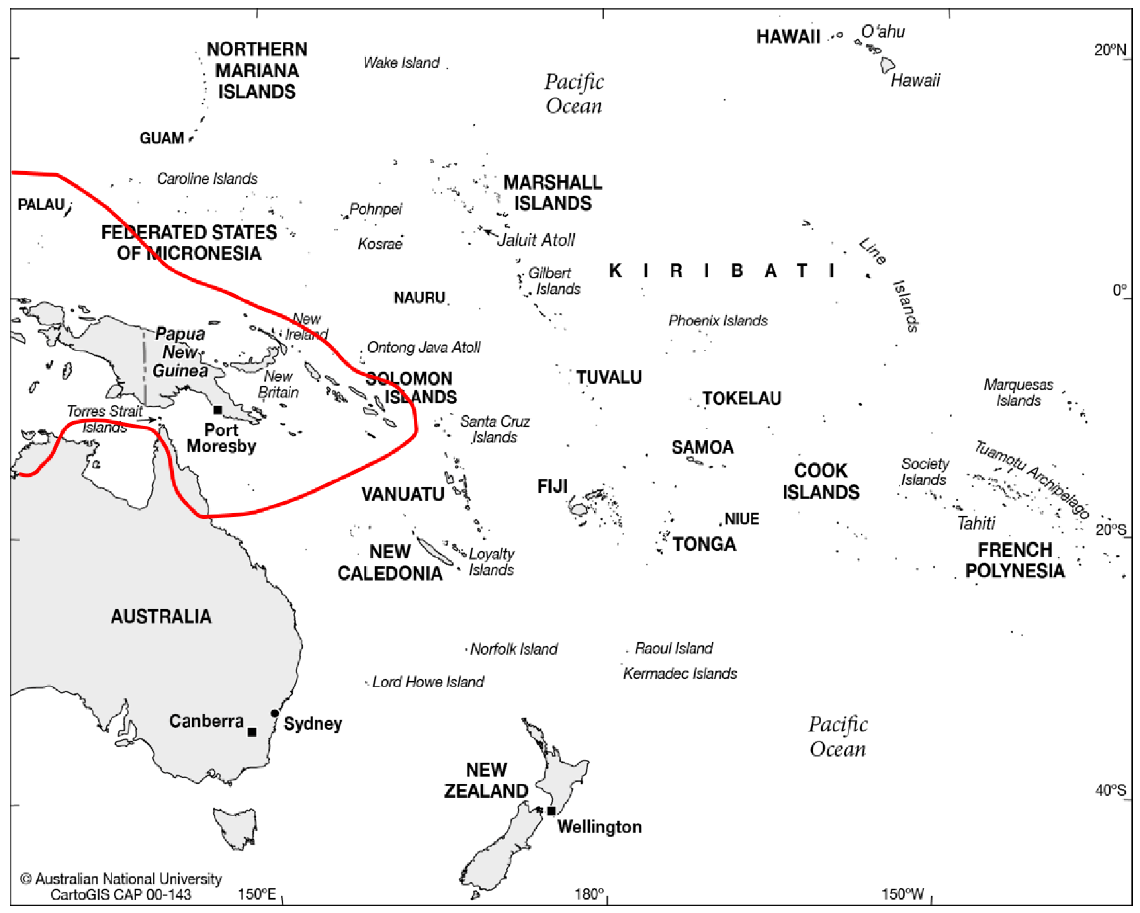
Fig. 14. Regional distribution of the genus Monoon (Annonaceae) in the Pacific. Base map sourced from CartoGIS, College of Asia and the Pacific, The Australian National University,